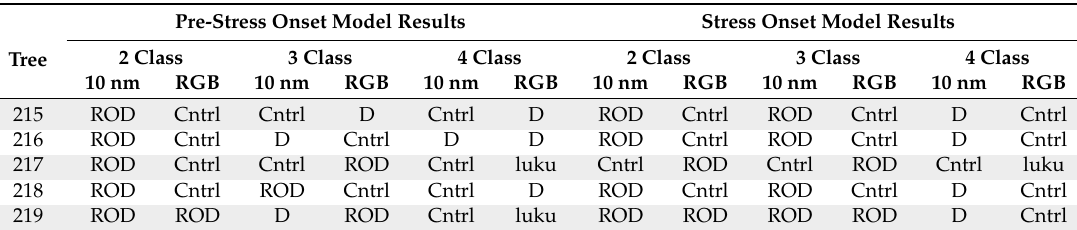
Table 2. Linear SVM Model Results for C . huliohia -Inoculated Felled Tree Branch Samples. Tree